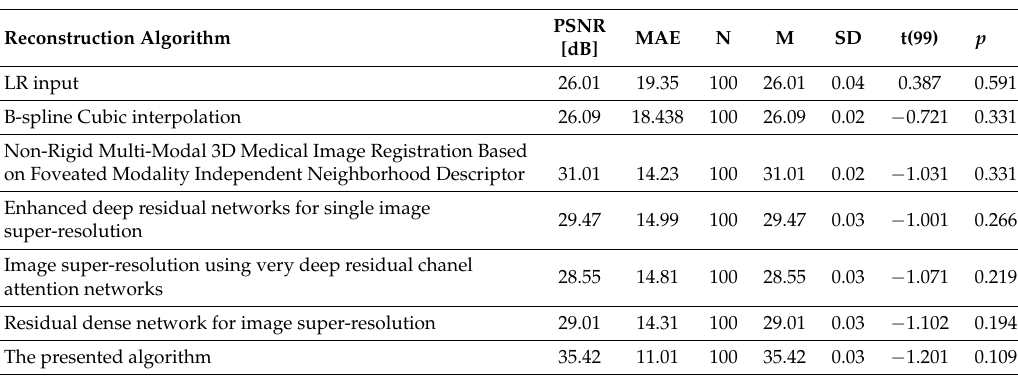
Table 7. Statistical parameters of the model performance metrics for in vivo trials, see Figure 8. Reconstruction Algorithm